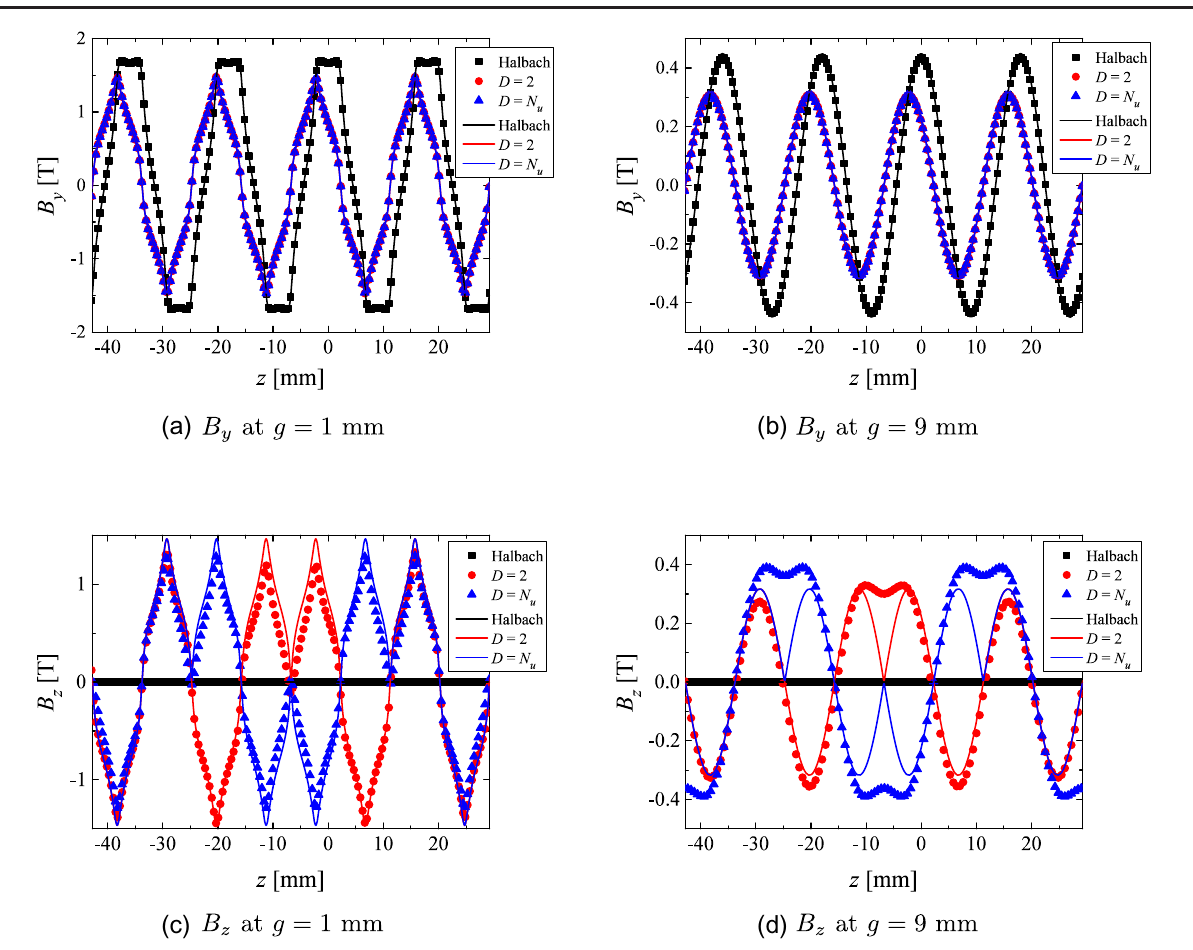
FIG. 5. Analytically (lines) and numerically (symbols) calculated magnetic field in the HU, the PCU ( D ¼ 2 ), and the PCU ( D ¼ N The joints are at z ¼ − 3 λ